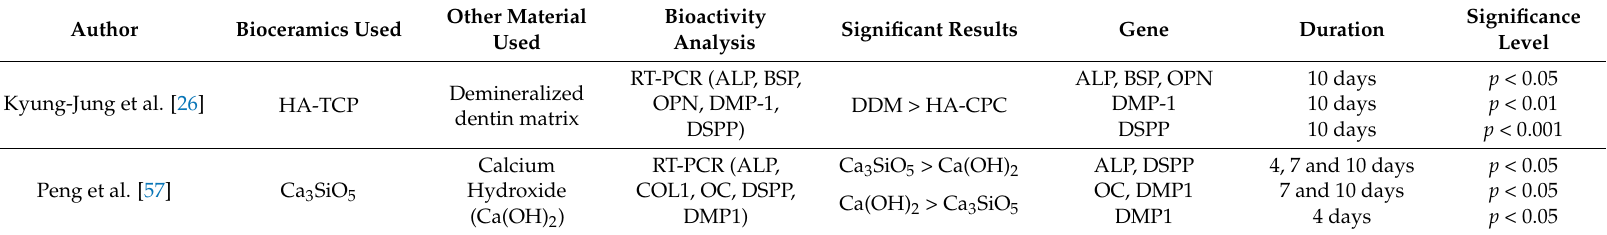
Table 10. Summary of the results of included studies showing significant differences between a bioceramic material and a non-bioceramic material for osteogenic, odontogenic and/or angiogenic gene expression.